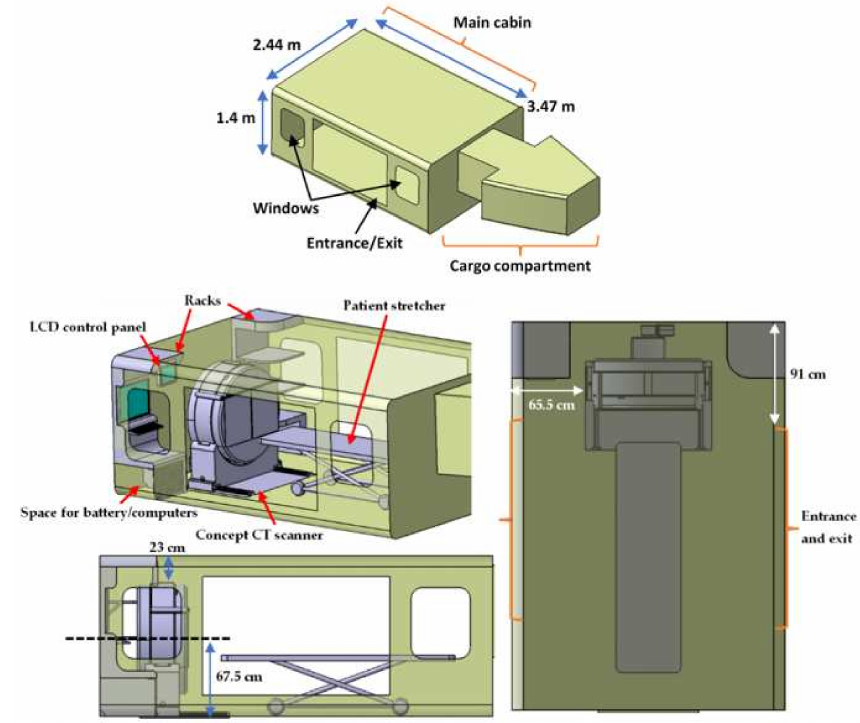
Figure 13. Conceptual layout of AW189 interior with proposed CT scanner